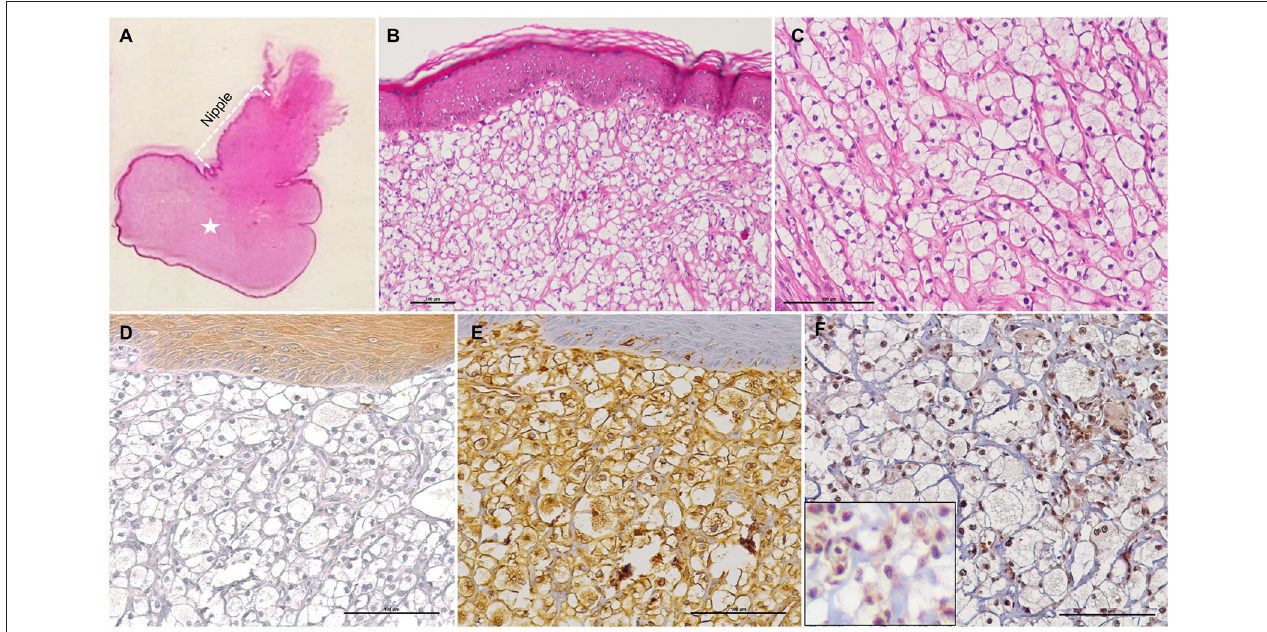
FIGURE 1 | Histological and immunohistochemical features of a hibernoma (pale cell variant) in the subepidermal area of the nipple in a bitch. (A) The subepidermal area of the nipple is distended by an expansile, benign tumor (white asterisk), HE stain. (B,C) The tumor is composed of round to polygonal neoplastic brown fat cells arranged into sheets and poorly defined lobules, separated by a fine fibrovascular stroma. The neoplastic cells show abundant vacuolated cytoplasm, and mild anisocytosis and anisokaryosis, HE stain. (D) The neoplastic cells are negative for cytokeratin AE1/AE3, but positive for Vimentin (E) and UCP1 [ (F) and higher magnification in the inset].